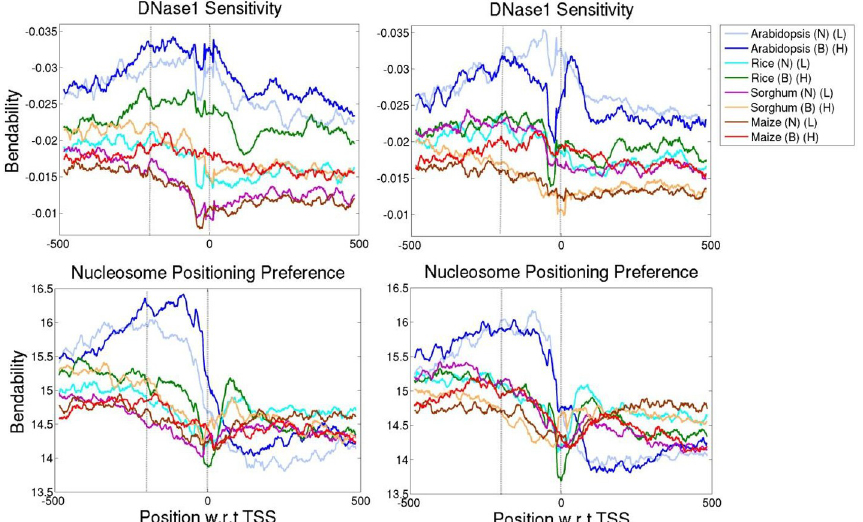
Fig 4. Bendability is plotted for the promoter region (-500 to +500) of top 10% and bottom 10% of the expression breadth (left panel) and level (right panel). Bendability or flexibility, trinucleotide secondary structural properties were measured by predicting DNaseI sensitivity and Nucleosome position preference (NPP). B stands for broadly expressed dataset and N narrowly expressed, whereas H represents highly expressed and L lowly expressed